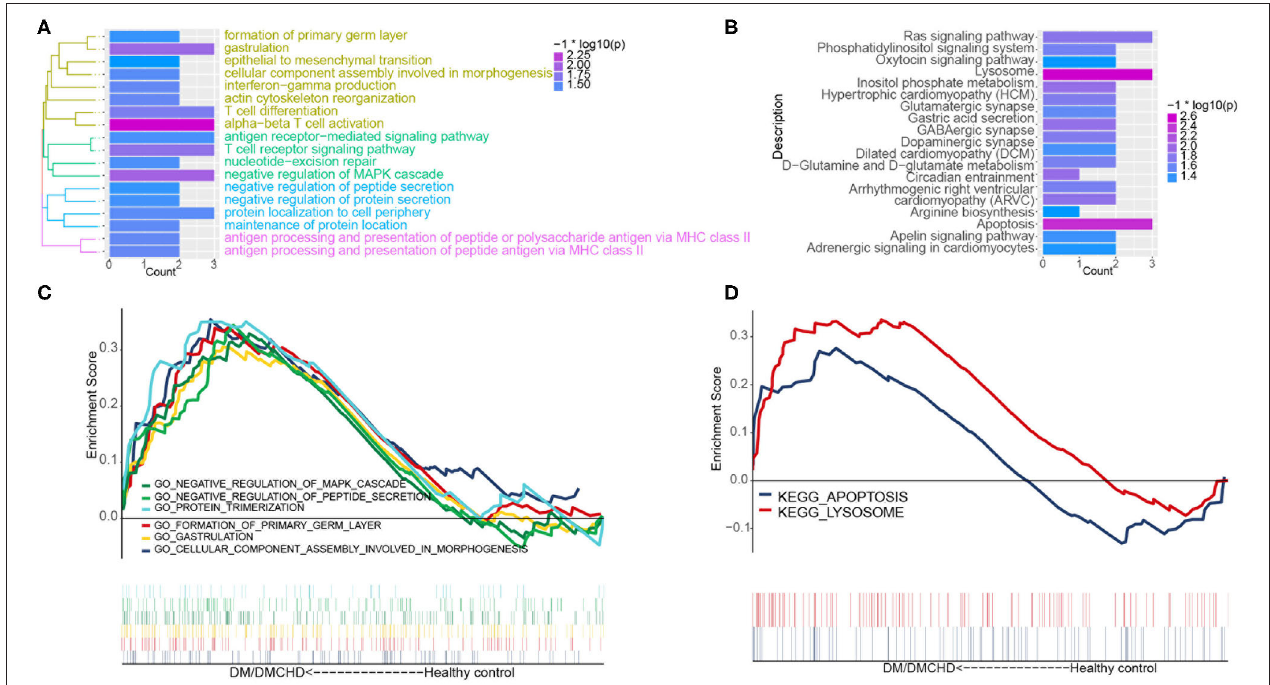
FIGURE 2 | The exploration of DM and DMCHD-related biological process and pathways using functional enrichment analysis. (A) Significantly enriched biological processes corresponding to genes in the light green module. P < 0.05 was considered significant. (B) Significant enrichment of KEGG pathways for genes in the light green module. P < 0.05 was considered significant. (C) Biological processes identified by gene set enrichment analysis and found to be significantly enriched in samples from patients with diabetes mellitus or both diabetes mellitus (DM) and coronary heart disease (DMCHD). KEGG, Kyoto Encyclopedia of Genes and Genomes. (D) Biological processes determined from gene clusters. DM, diabetes mellitus; DMCHD, diabetes mellitus and coronary heart